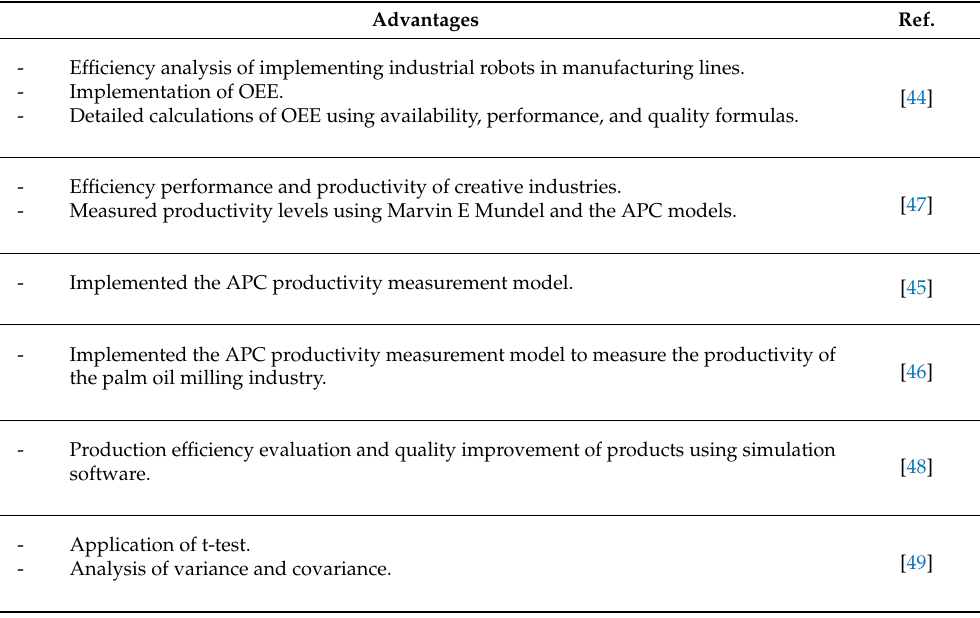
Table 6. Summary of key findings of recent studies on usability evaluation